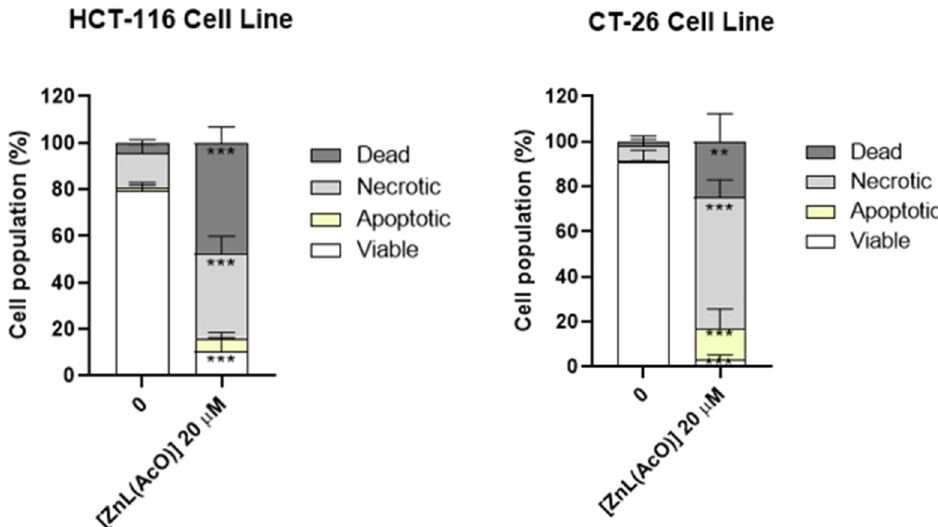
Figure 2. Percentage of viable, apoptotic, necrotic, and dead HCT-116 and CT-26 cells cultured in a 2D setting, obtained by Alexa Fluor ® 488 annexin V/Dead Cell Apoptosis assay after 24 h of incubation with [ZnL(AcO)] at 20 µM. Results correspond to the cell population expressed as mean percentage (%) ± SD of three independent experiments (** p < 0.01, *** p < 0.001 vs. control).